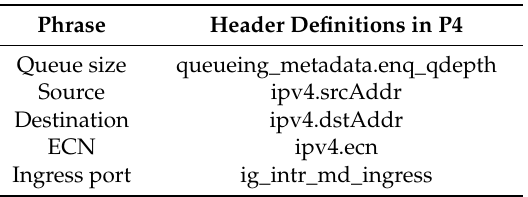
Table 1. Header and metadata fields.